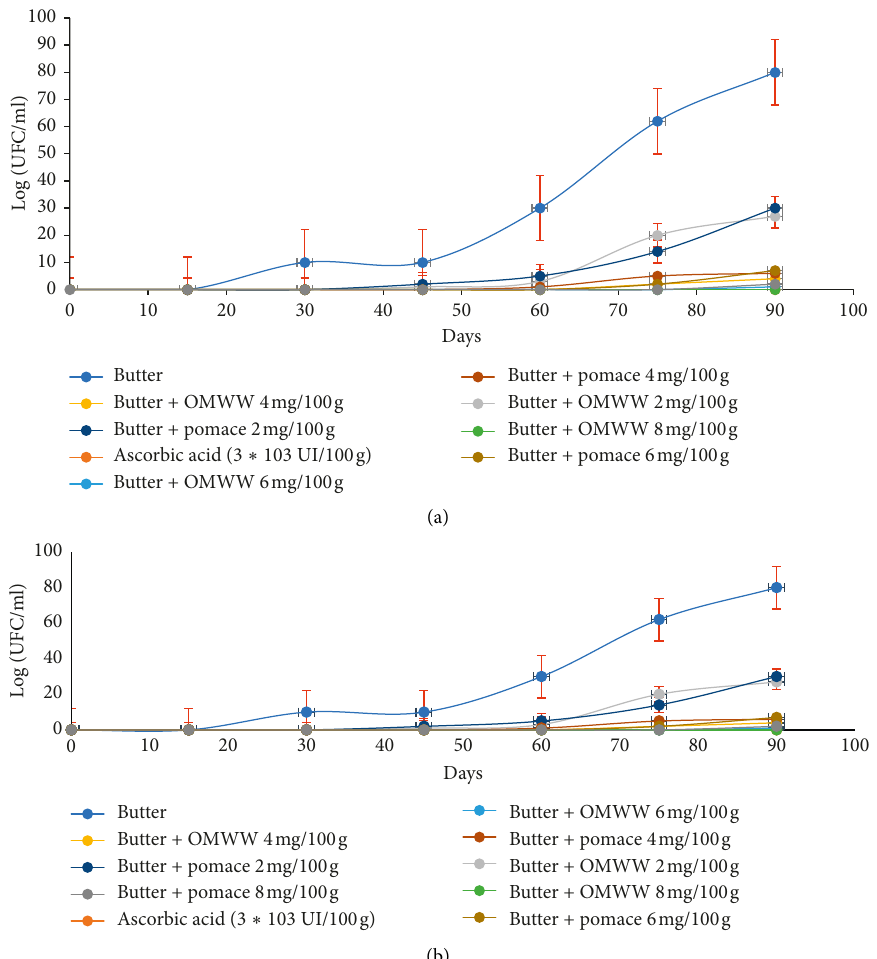
Figure 8: Evolution of FTAM butter populations as a function of time. (a) Samples stored at 25 ° C. (b) Samples stored at 60 °